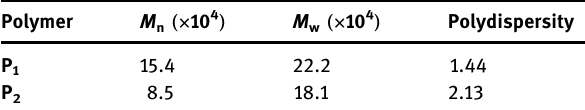
Table 1: GPC data of the norbornene polymers*